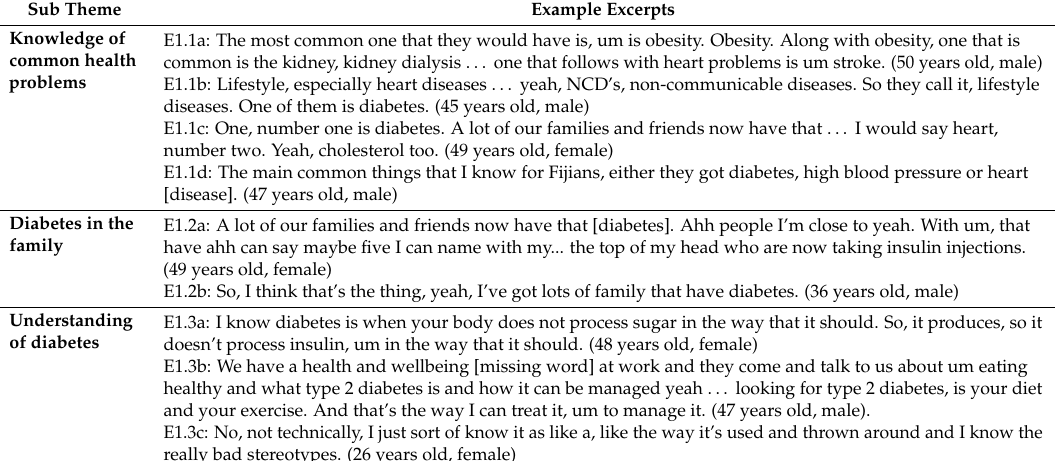
Table 2. Excerpts for knowledge and awareness of diabetes and